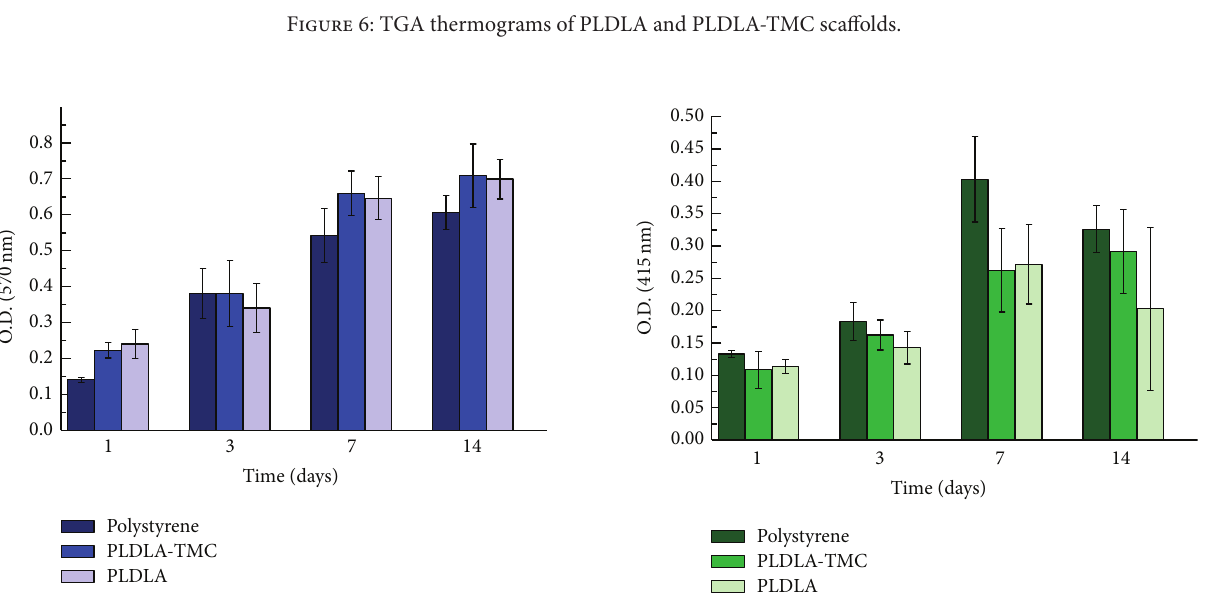
Figure 8: Alkaline phosphatase activity of SaOS-2 on scaffolds. Values are expressed as means ± SD, 𝑛 = 6